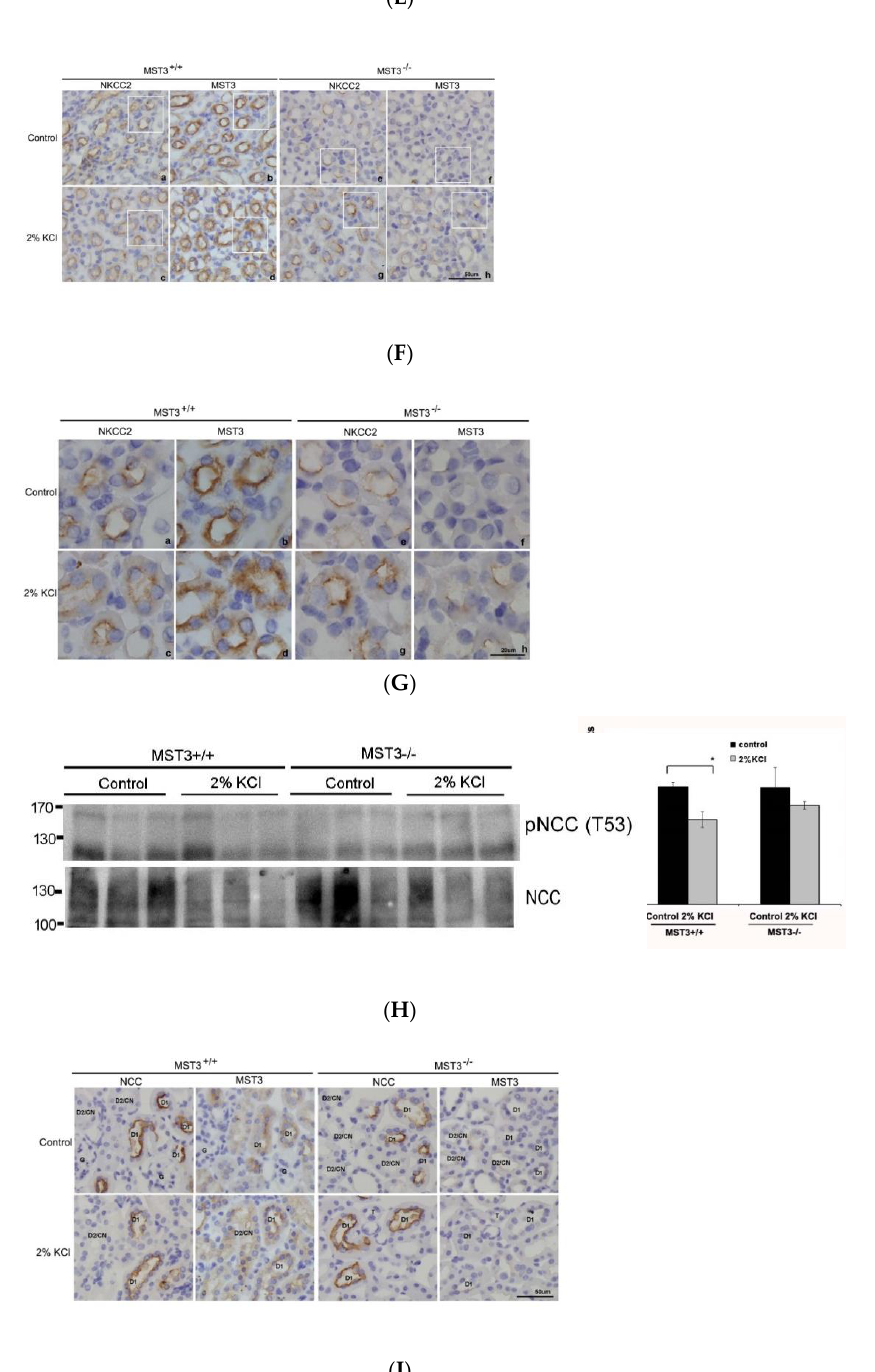
Figure 4. WNK4 and WNK4-regulated channels in mice fed 2% KCl diets. Western blot analysis of ( A ) WNK4, ( B ) BK, and ROMK, ( C ) γ-ENaC, ( E ) NKCC2, and p-NKCC2, and ( H ) NCC and p-NCC in the kidney of MST +/+ and MST3 −/− mice 8 weeks after the treatment with the control and 2% KCl diets for 16 days ( n = 3 animals/group). The bar graph shows quantification of Western blot relative to the levels in the control group of WT mice. * p < 0.05 vs. the control group. Serial sections of the kidney of WT and MST3 − / − mice fed the control and 2% KCl diets were stained for γ -ENaC ( D ), NKCC2 ( F , G , outlined images of F were enlarged using a 100 × objective.), NCC ( I ), and MST3. G, glomerular; D1, early distal convoluted tubule; D2, late distal convoluted tubule; CN, connecting